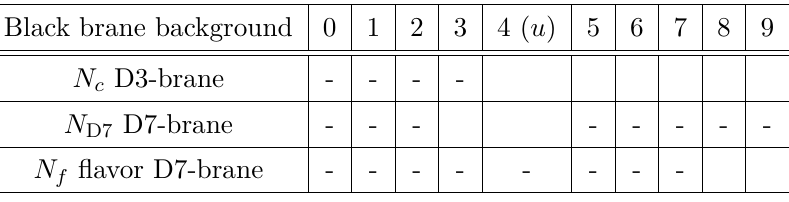
Table 3 . The D-brane configuration in the black brane background.